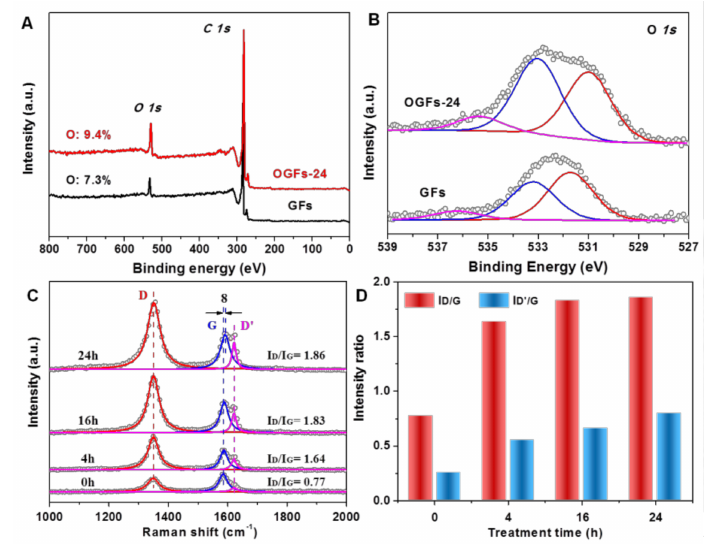
Figure 5. ( A ) Survey X-ray photoelectron spectroscopy (XPS) of OGFs-24 in comparison with pristine GFs, ( B ) deconvolution O1s present the oxygen species on the surface of the samples, ( C ) Raman spectra, and ( D ) I D / I G and I D’ / I G ratios of the pristine GFs and the OGFs after acid treatment with various